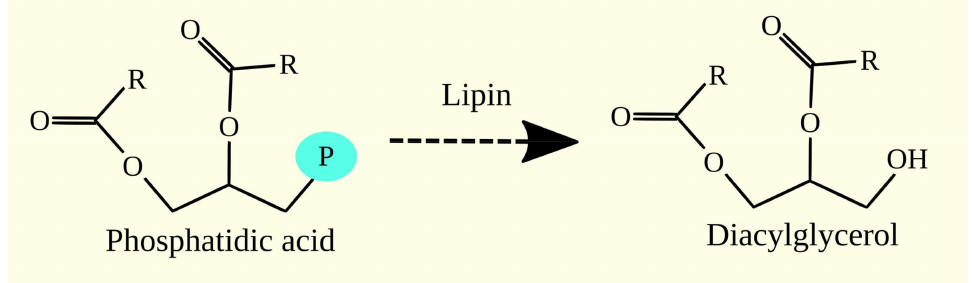
Figure 5. Lipins participate in the de novo synthesis of glycerophospholipids and triacylglycerol during the generation of diacylglycerol. They catalyze the reaction converting phosphatidic acid to diacylglycerol.